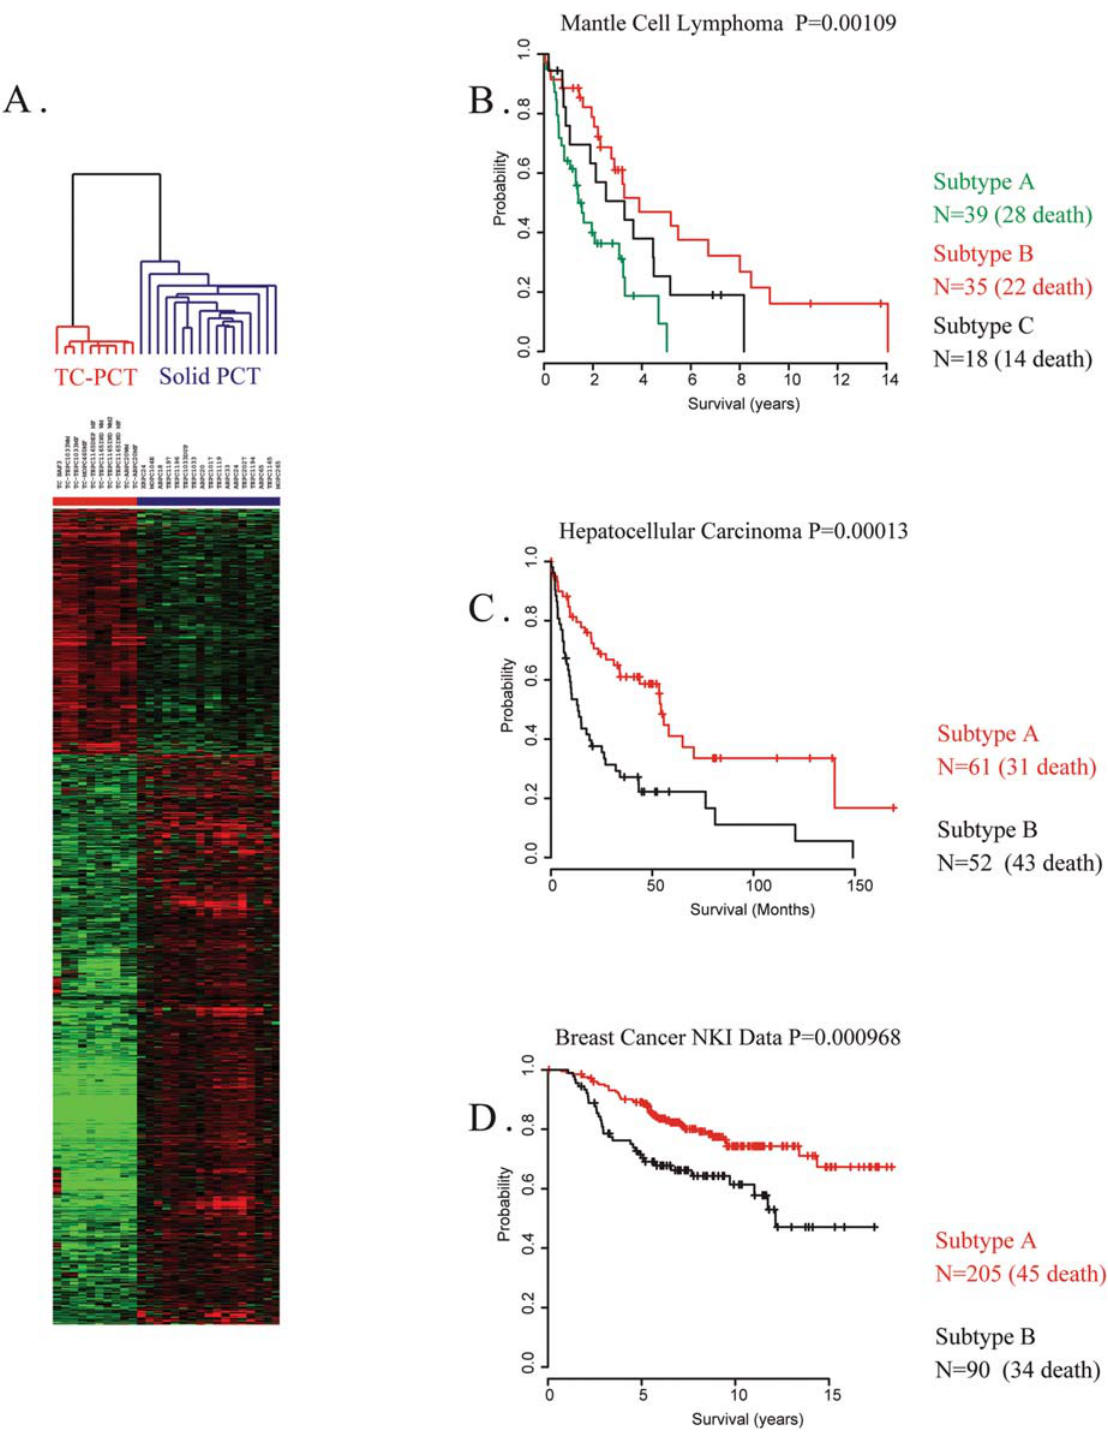
Figure 1. Mouse plasma cell tumor tissue culture (PCT-TC) signature and survival analysis of human cancer patients 27 RNA samples from 17 solid mouse plasma cell tumors and 10 tissue cultured mouse PCT-TC cell lines (including Baf3, a pre-B cell line) were used for the generation of PCT-TC signature. A. Mouse plasma cell tumor tissue culture signature. 1162 genes showing significant differences in expression between solid PCTs and tissue-cultured PCTs were selected by SAM analysis at the 99-percentile confidence level with a 0.001 FDR. B–D. Kaplan-Meier survival analysis of human cancer patients groups generated by unsupervised cluster analysis with mouse PCT-TC signature. B. Survival analysis of human mantle cell lymphoma patients group [12] generated by unsupervised cluster analysis with 694 orthologs of the mouse PCT-TC signature genes. C. Survival analysis of human liver cancer patients [13] generated by unsupervised cluster analysis with 971 orthologs of the mouse PCT-TC signature genes. D. Survival analysis of human breast cancer patients [2,3,15] generated by unsupervised cluster analysis with 470 orthologs of the mouse PCT-TC signature genes.